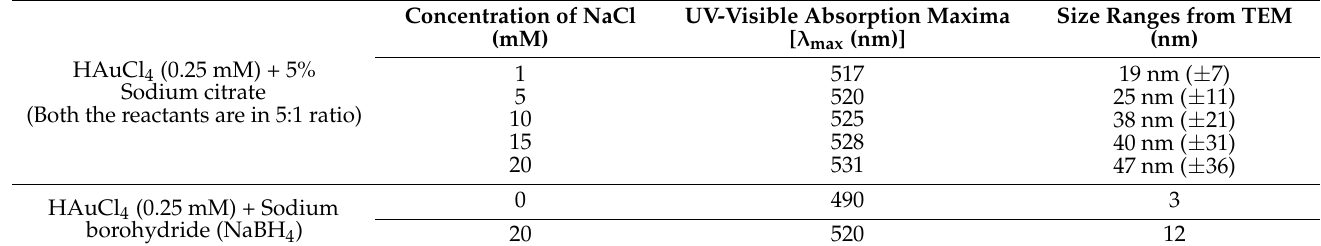
Table 1. The effect of Cl − ion concentration and reductant on AuNPs